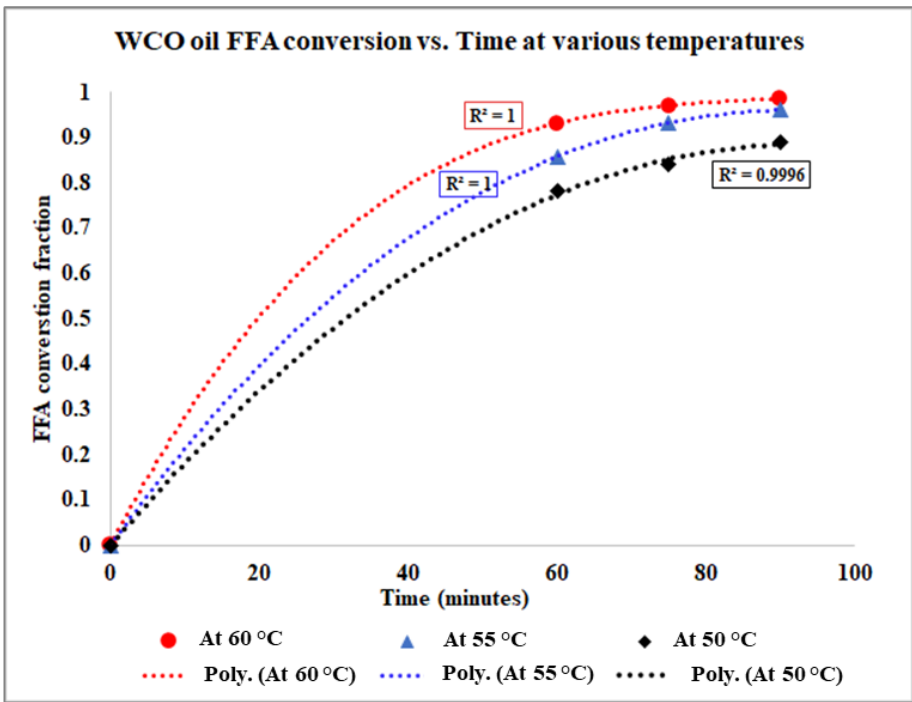
Figure 7. WCO oil FFA conversion vs. time at various temperatures. Based on the regression equations found for FFA removal against time, the graph plot between ln[ C A 0 (1 − X E )] and ln( dX E / dt ) to determine the reaction order and the reaction rate constant is shown in Figure 3 following Equation (1).